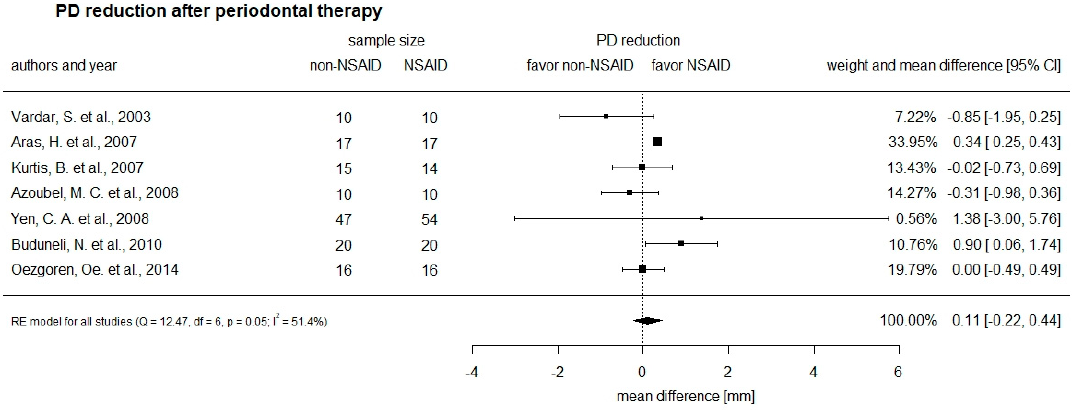
Figure 2. Forest plot comparing probing pocket depth (PD) reduction between non-NSAID and NSAID groups.